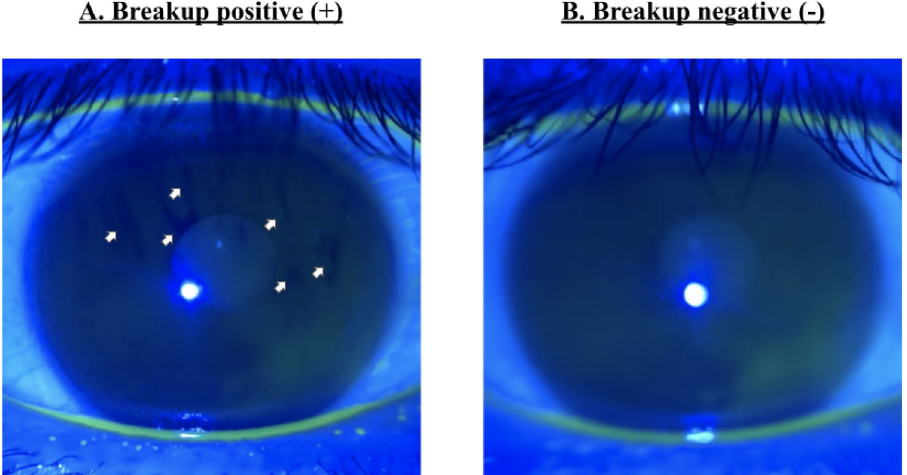
Figure 2. Annotation criteria. ( A ) The frames containing one or more black spots (white arrow) are classified as “breakup positive(+)”. ( B ) The frames that did not contain any black spot are classified as “breakup